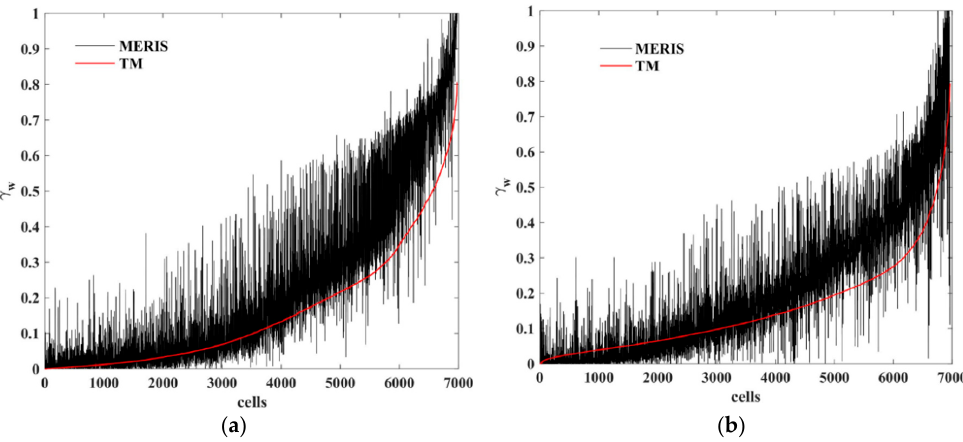
Figure 12. Mean fractional abundance estimated by spectral indices unmixing method over the 1.2 km × 1.2 km cells of an arbitrary grid in ( a ) April 2008 and ( b ) May 2009 images indices based spectral unmixing.